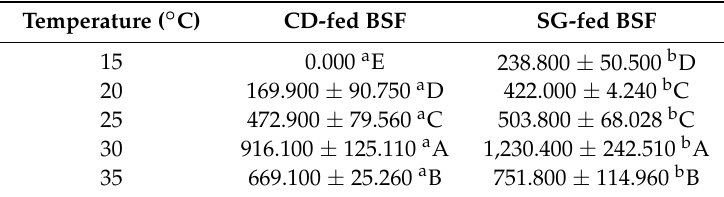
Table 5. Mean ( ± SD) number of eggs produced by black soldier flies reared on two different organic substrates at five different temperature regimes.